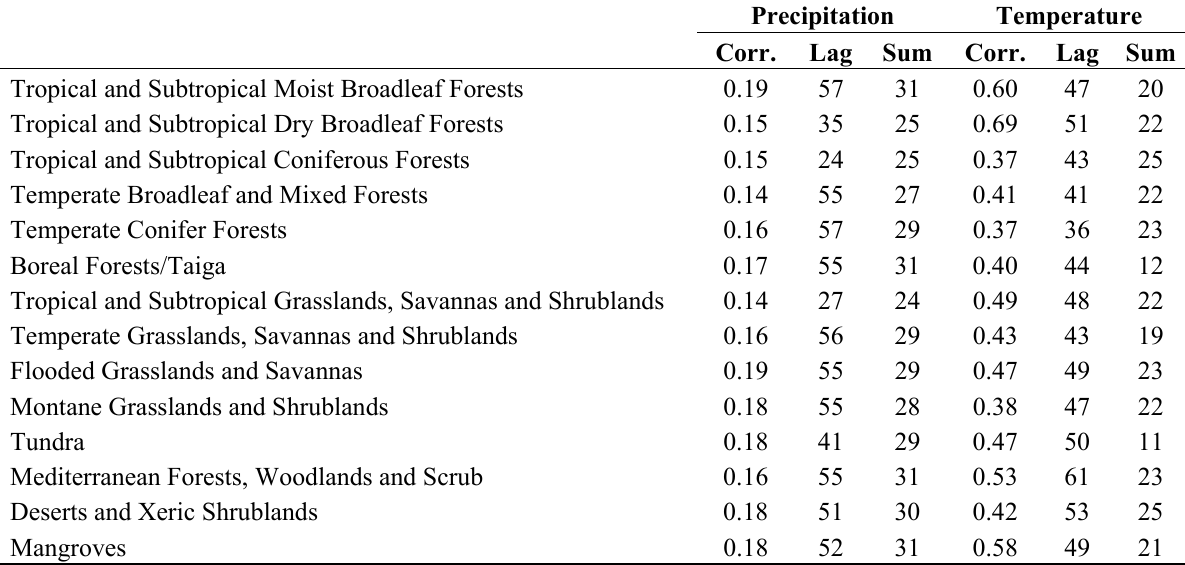
Table 2. Summary of the precipitation and temperature SD of correlation (Corr.) to EVI, lag (days) and summation period (days) in WWF biomes.